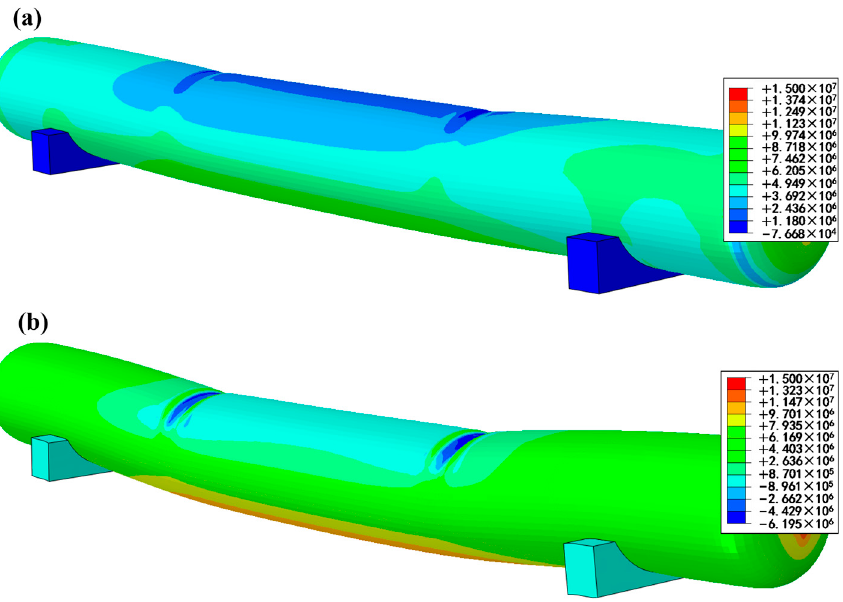
Figure 14. The deformed patterns of the FE model: ( a ) initial loading; ( b ) close to ultimate load.